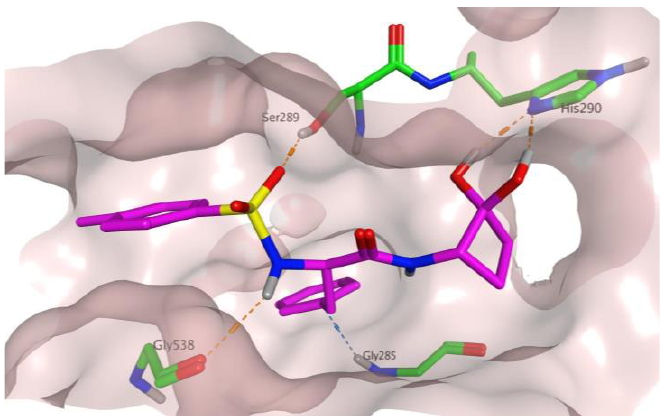
Figure 2. Docking image showing binding interactions of compound 6 ( N -tosyl-D-Phe cyclobuta-